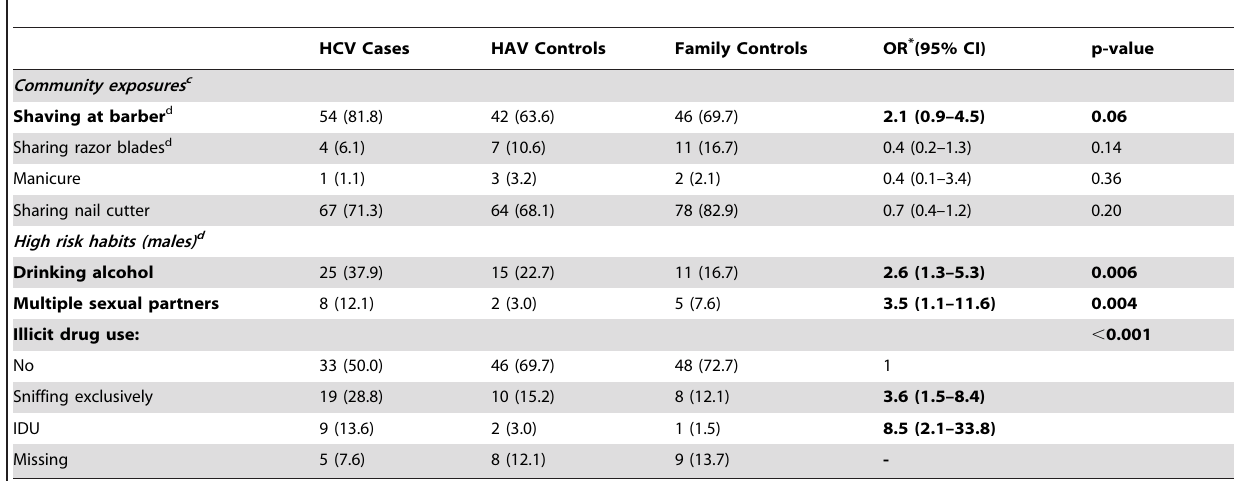
Table 3. Community exposures and high risk habits among acute hepatitis C cases and controls sex- and 6 1 year age-matched, Greater Cairo, 2002-7.